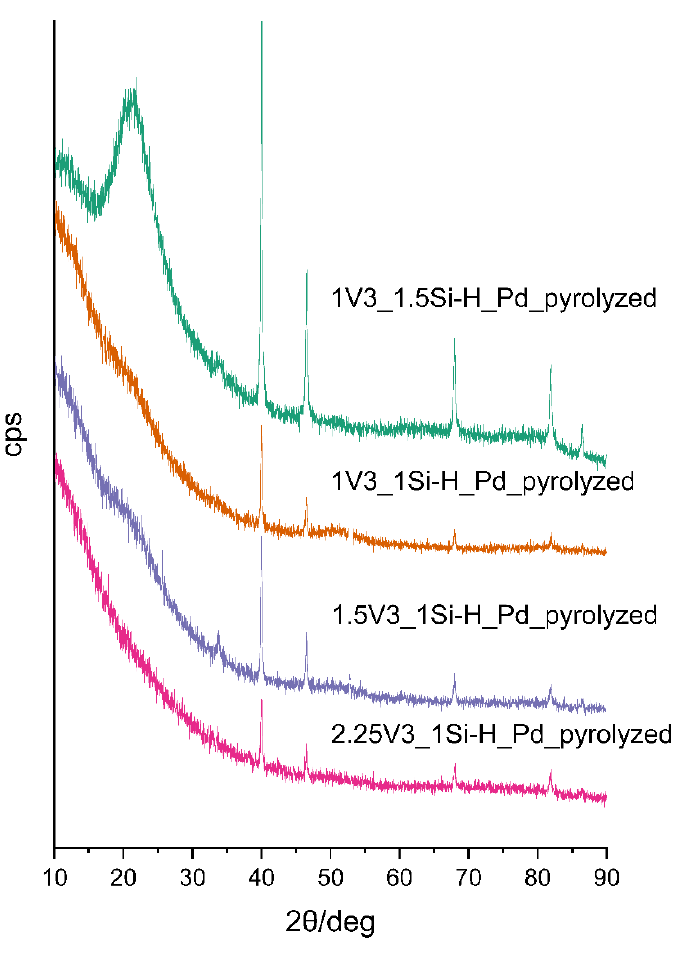
Figure 4. XRD patterns of the pyrolyzed Pd-containing V 3 polymer-based polyHIPE.